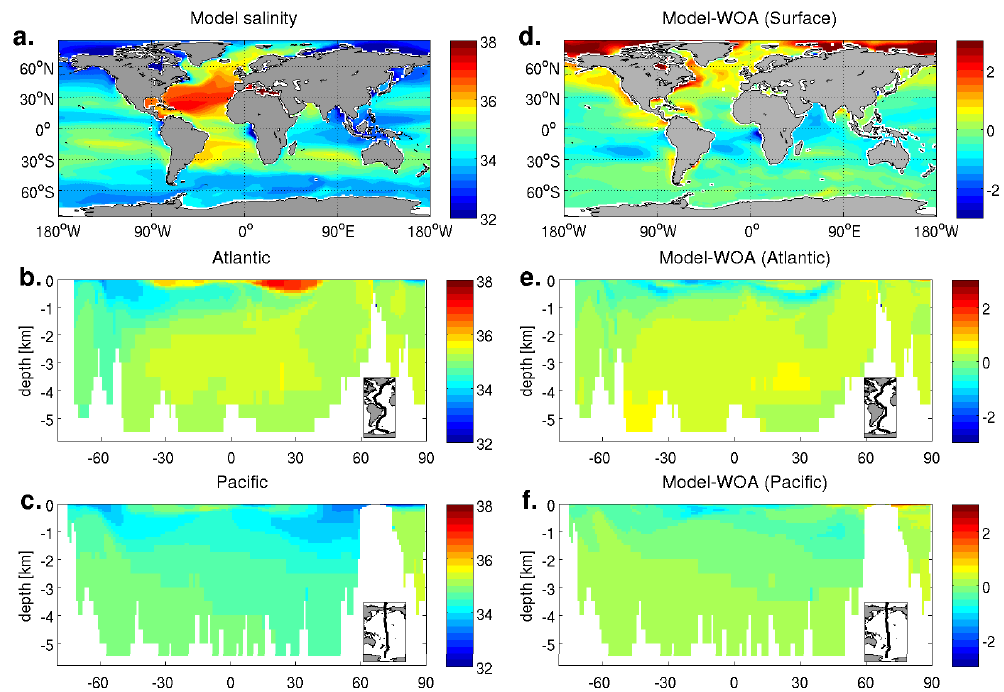
Fig. 4. Distribution of ocean salinity from model simulation (left) and difference between the model and climatological estimates (right) (WOA, Antonov et al., 2010) for the surface (a, d) , Atlantic (b, e) and Pacific (c, f) vertical sections. Units are in